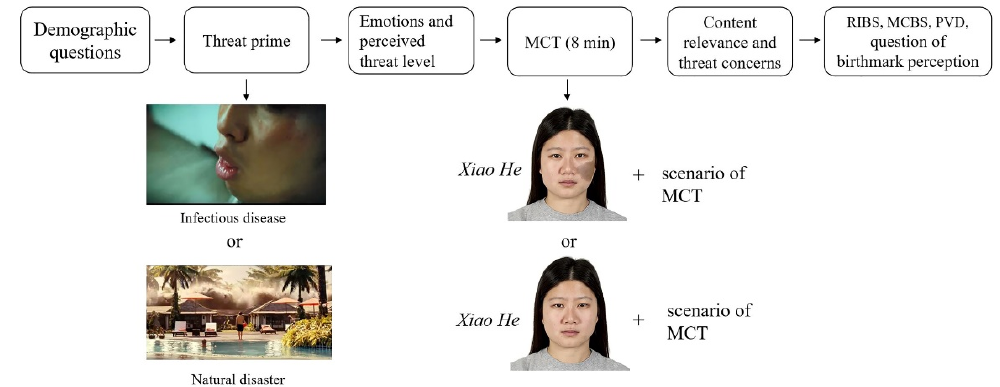
Figure 1. Procedure for female participants in Study 1.